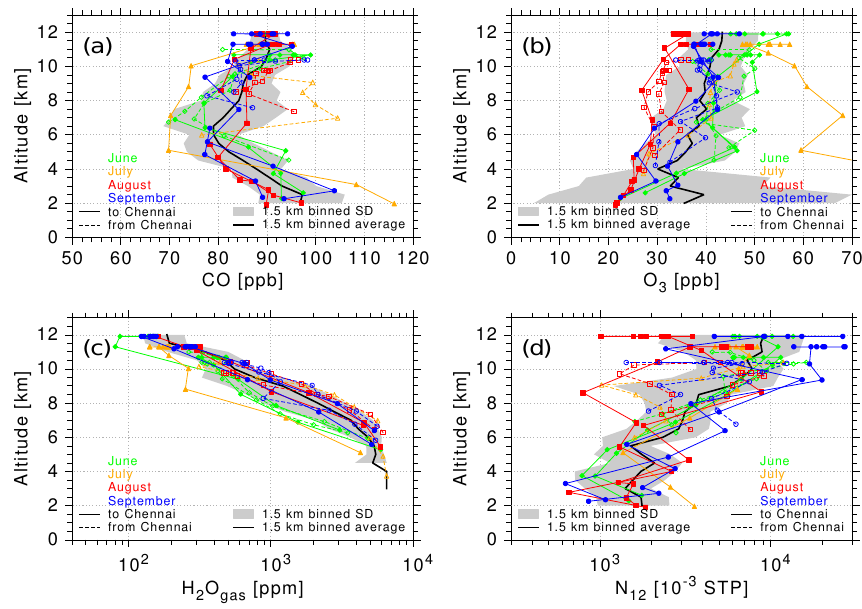
Figure 9. Vertical profiles of CO (a) , O 3 (b) , water vapour (c) , and number concentration of Aitken-mode aerosol particles N 12 at STP (273.15K, 1013.25hPa) ( d ) between 2km and 12km during descent into (solid lines and filled symbols) and ascent from (dashed lines and open symbols) Chennai. The colours indicate the flight month, the black line is the mean over all flights, and the grey shading indicates the 1 σ standard deviation around the mean (both calculated over moving 1.5km altitude bins). Note the logarithmic x axis for water vapour (c) and aerosol particles (d)